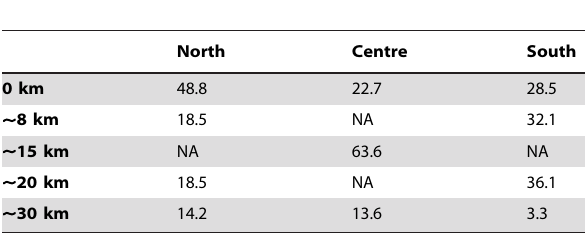
Table 3. Percentage of post-settlement dispersal in each of the three regions